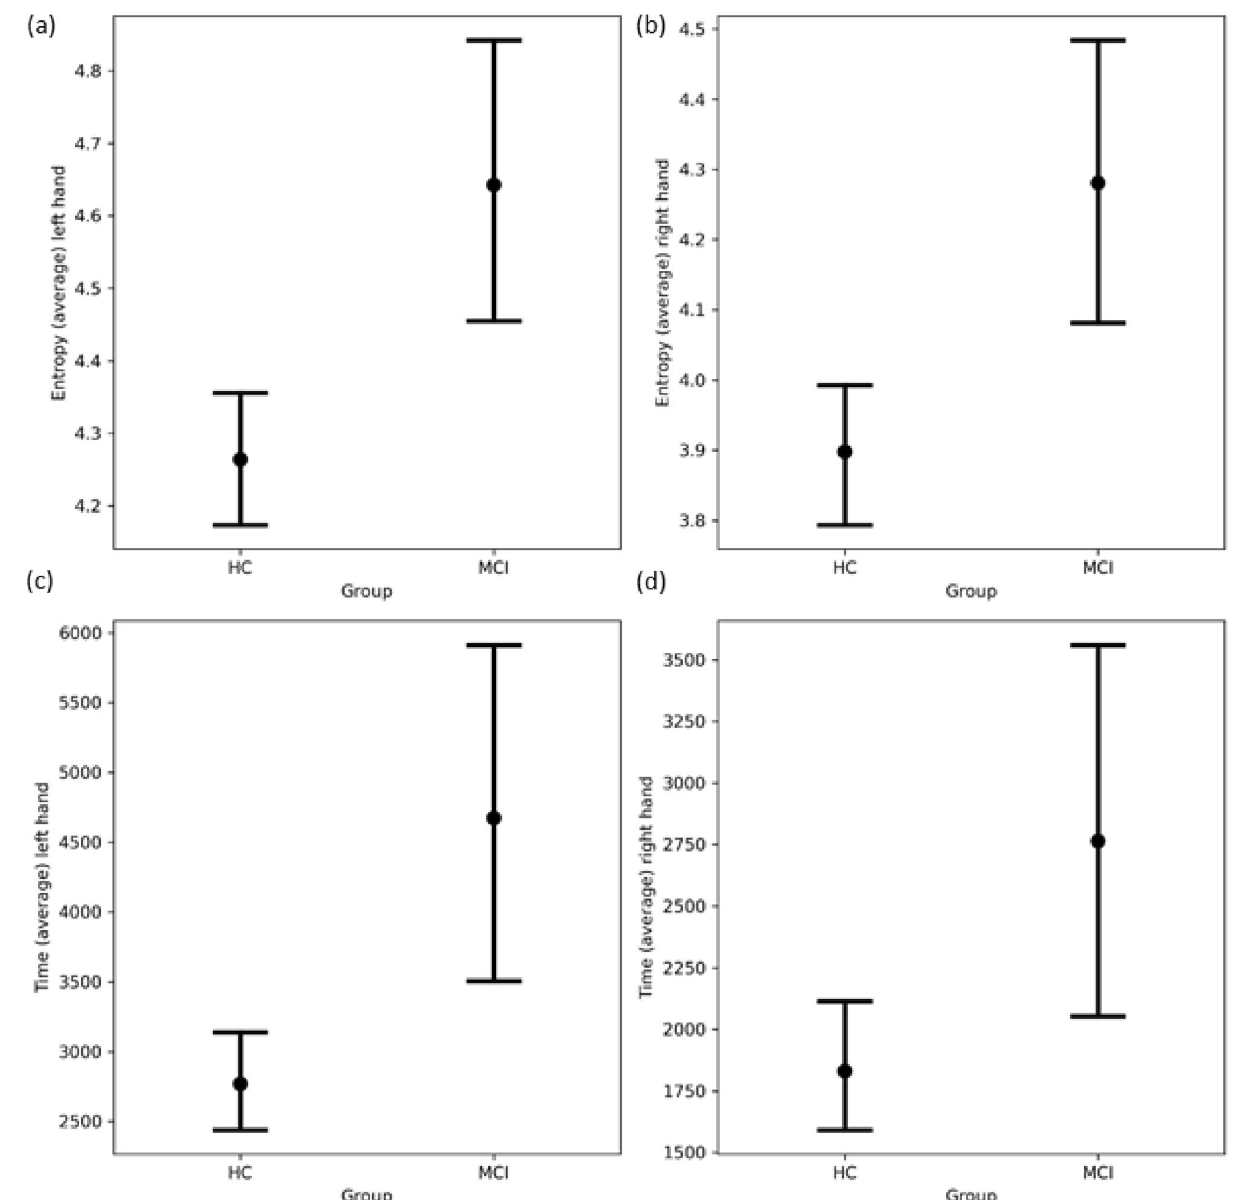
Figure 1. Error bars of intergroup comparisons of patients with MCI and healthy controls. Patients had significantly higher entropy in the movements and required longer time during the motor task. Difference is more characteristic in the left hand. All graphs demonstrate significant differences (p < 0.05). HC: healthy control; MCI: mild cognitive